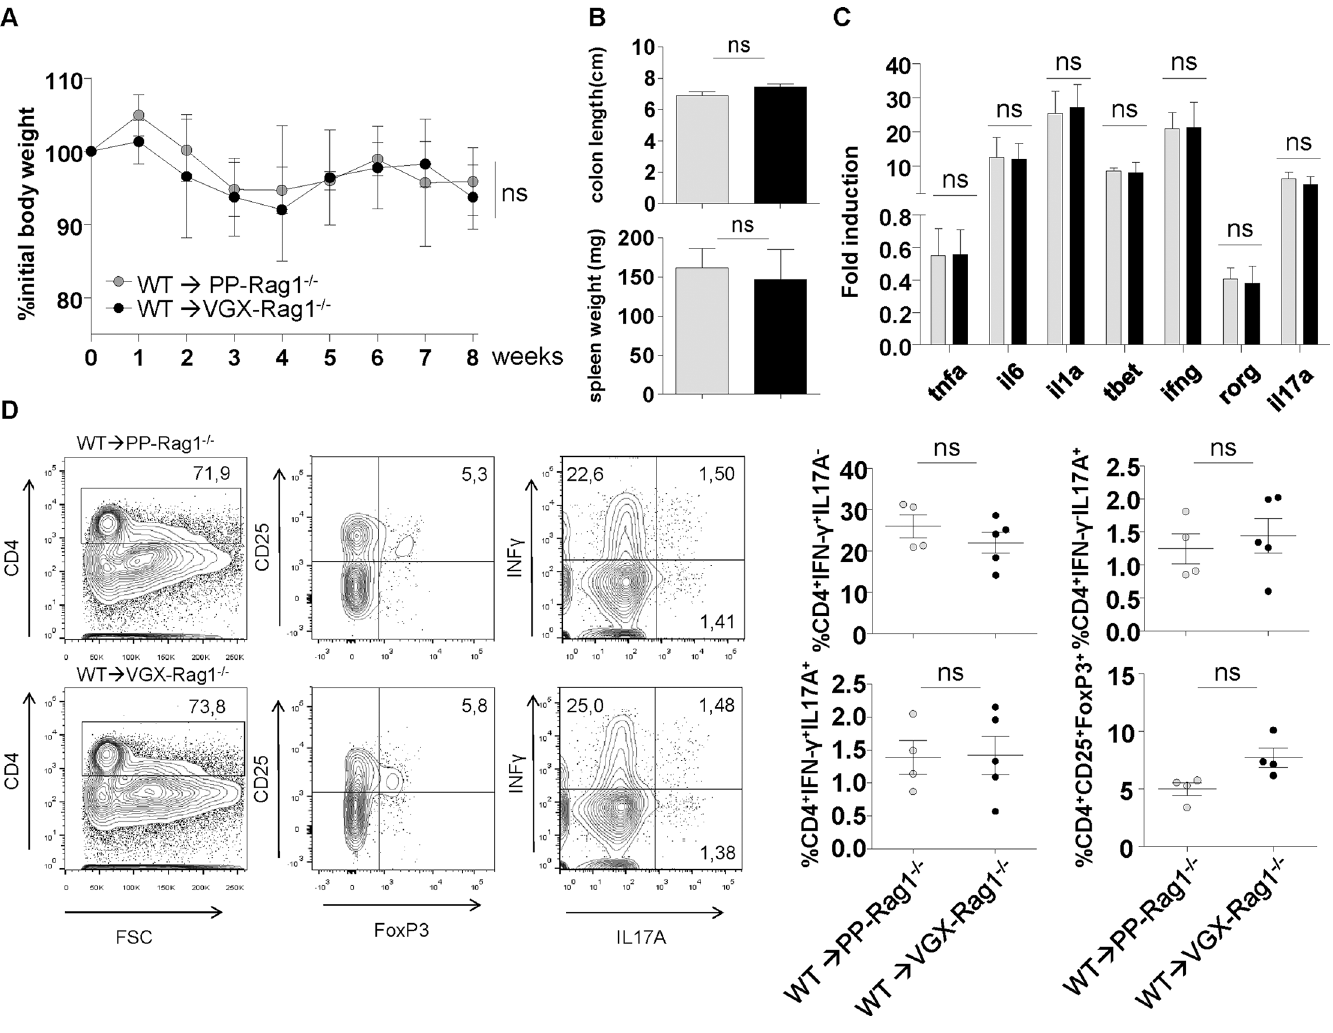
Figure 3. Vagotomy does not affect the development and the severity of T cell transfer-induced chronic colitis. Rag1 –/– mice were sub- jected to vagotomy (VGX) or pyloroplasty (PP) 2 wks before adoptive transfer of naïve T cells. (A) Body weight loss was followed over time in VGX-Rag1 -/- mice injected with WT naïve T cells (WT → VGX-Rag1, black) and in PP-Rag1 -/- mice injected with WT naïve T cells (WT → PP-Rag1, gray). Statistical significance was determined using a multivariate linear model after a post-hoc Bonferroni-Holm cor- rection (ns, not significant). (B) Eight weeks after T cell transfer, colon length and spleen weight were measured in WT → VGX-Rag1 and WT → PP-Rag1 mice. (C) Inflammatory gene expression was quantified via q-PCR in colonic tissue. tnfa , il6 , il1a , tbet , infg , rorc and il17a mRNAs were analyzed. (C) Gene expression levels are shown as fold induction on non-injected naïve Rag-1 -/- . (D) Representative flow cytometry dot plots and the frequencies of T helper cell subsets (IFN- γ + IL-17A - , IFN- γ + IL-17A + , IFN- γ - IL-17A + ) and Treg (CD25 + FoxP3 + ) were showed. Dots represent individual mice. Data are expressed as mean ± SEM. Statistical significance was determined with the unpaired Student t-test for colon length, spleen weight, gene expression level and flow cytometry analysis (ns, not